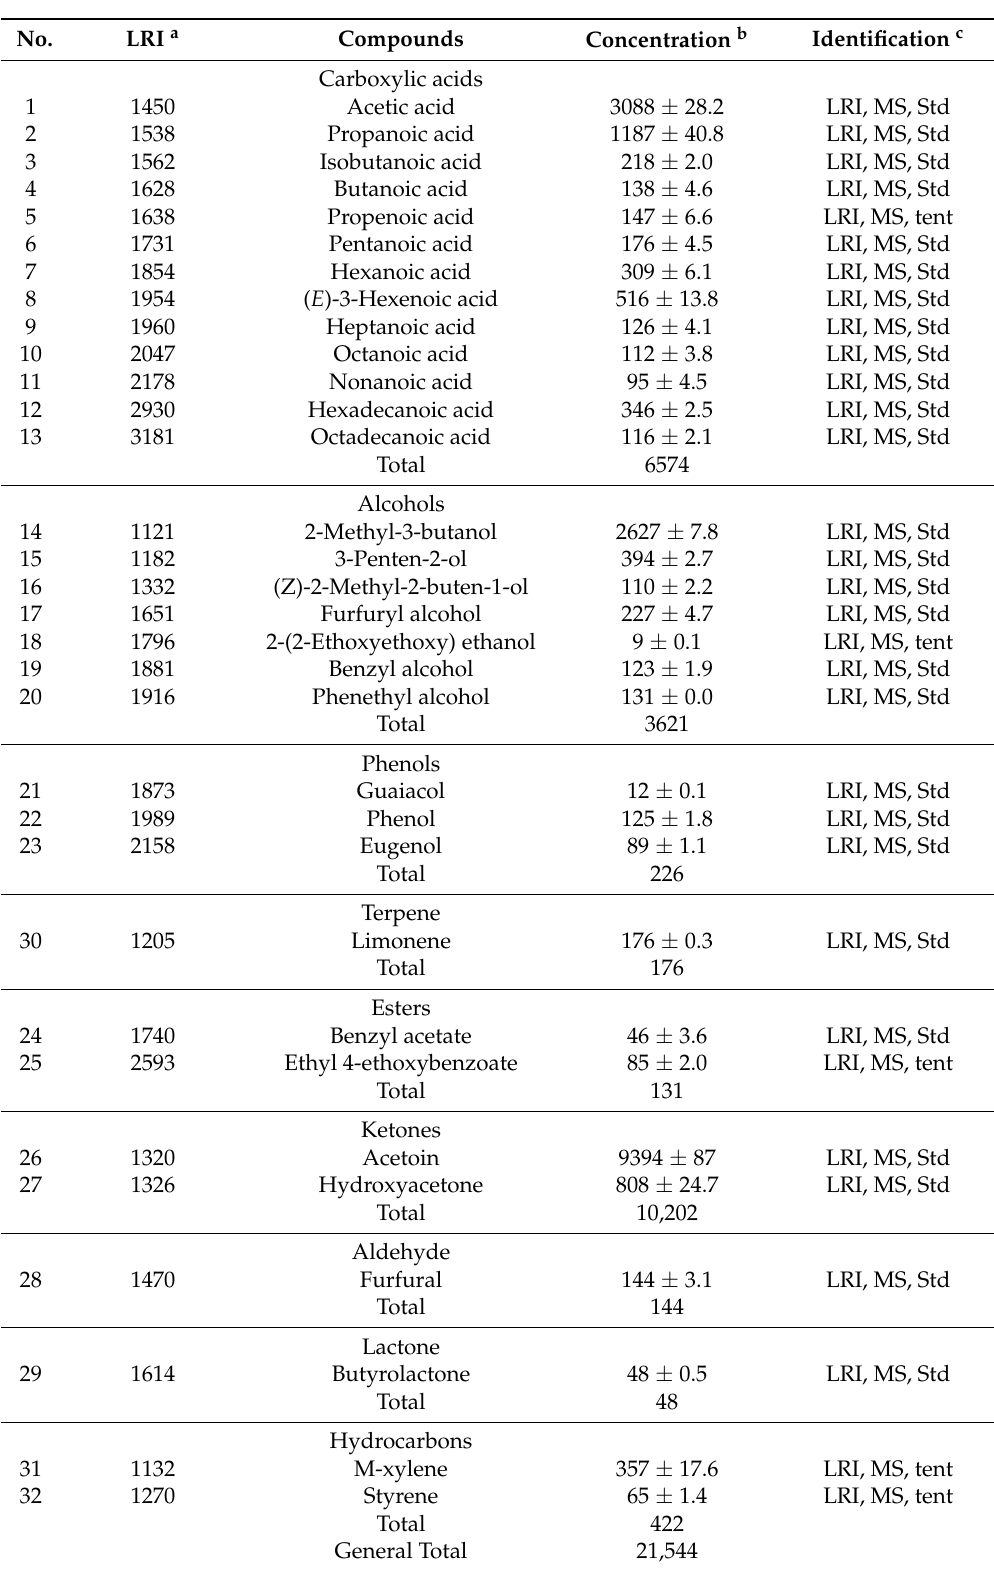
Table 1. Volatile compounds of black cumin seed